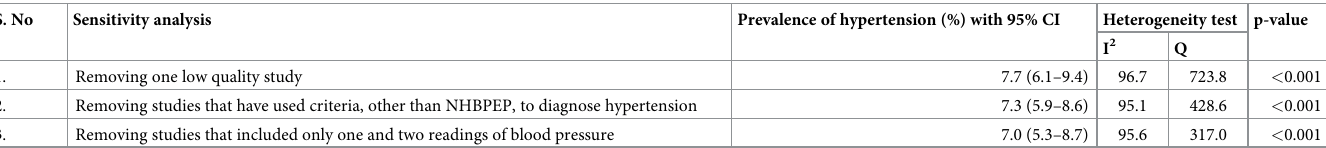
(e.g. NHBPEP criteria, modified ATP criteria and cut-off arbitrarily decided by authors [49, 52, 53]). Other reasons could be natural differences among the individuals included in the Table 3. Results for sensitivity analysis for the prevalence of hypertension among